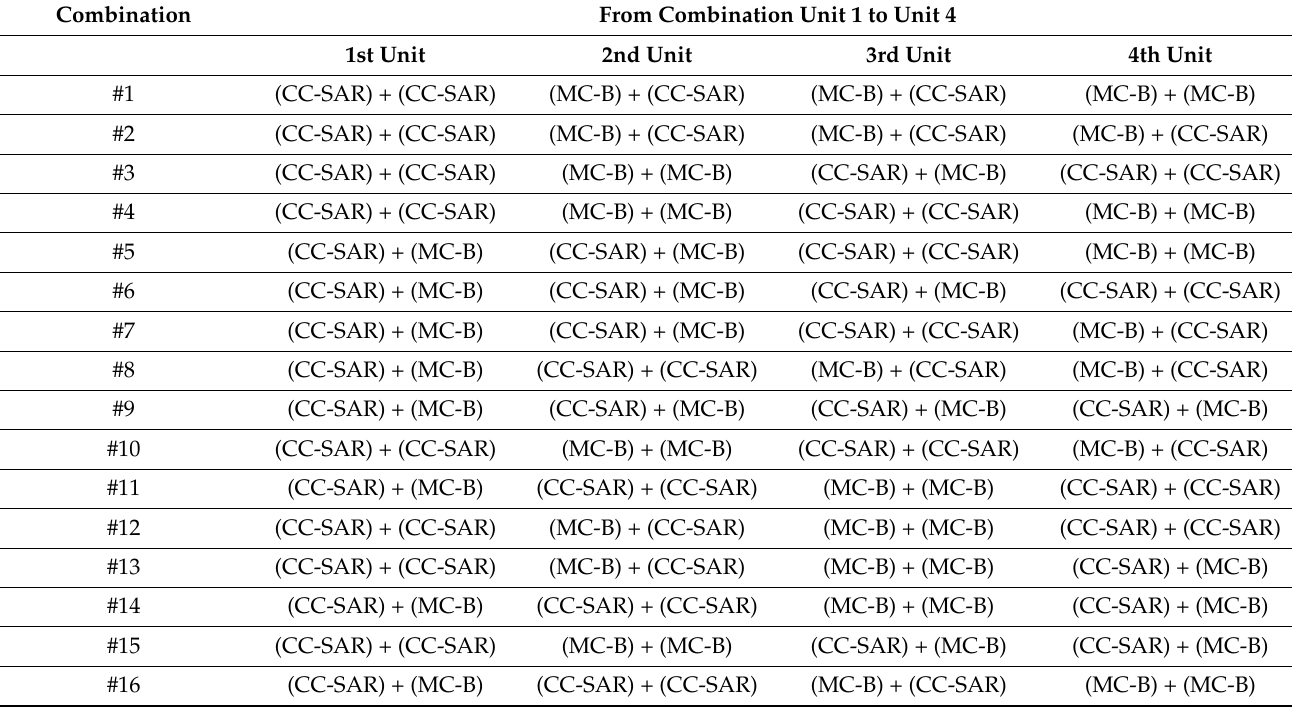
Table 4. Full factorial combination for the four combination units.